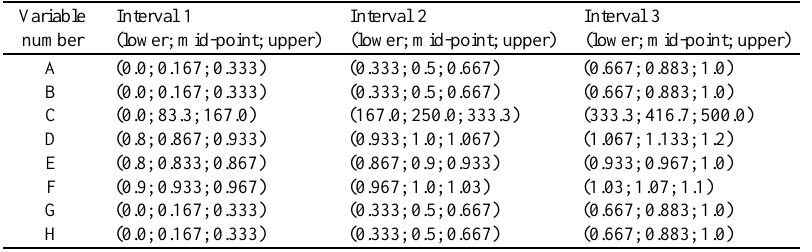
Fig. 6. Full factorial design of computer experiments (8 variables, 2 levels). Table 2 Design of experiments based on orthogonal arrays (3 levels)